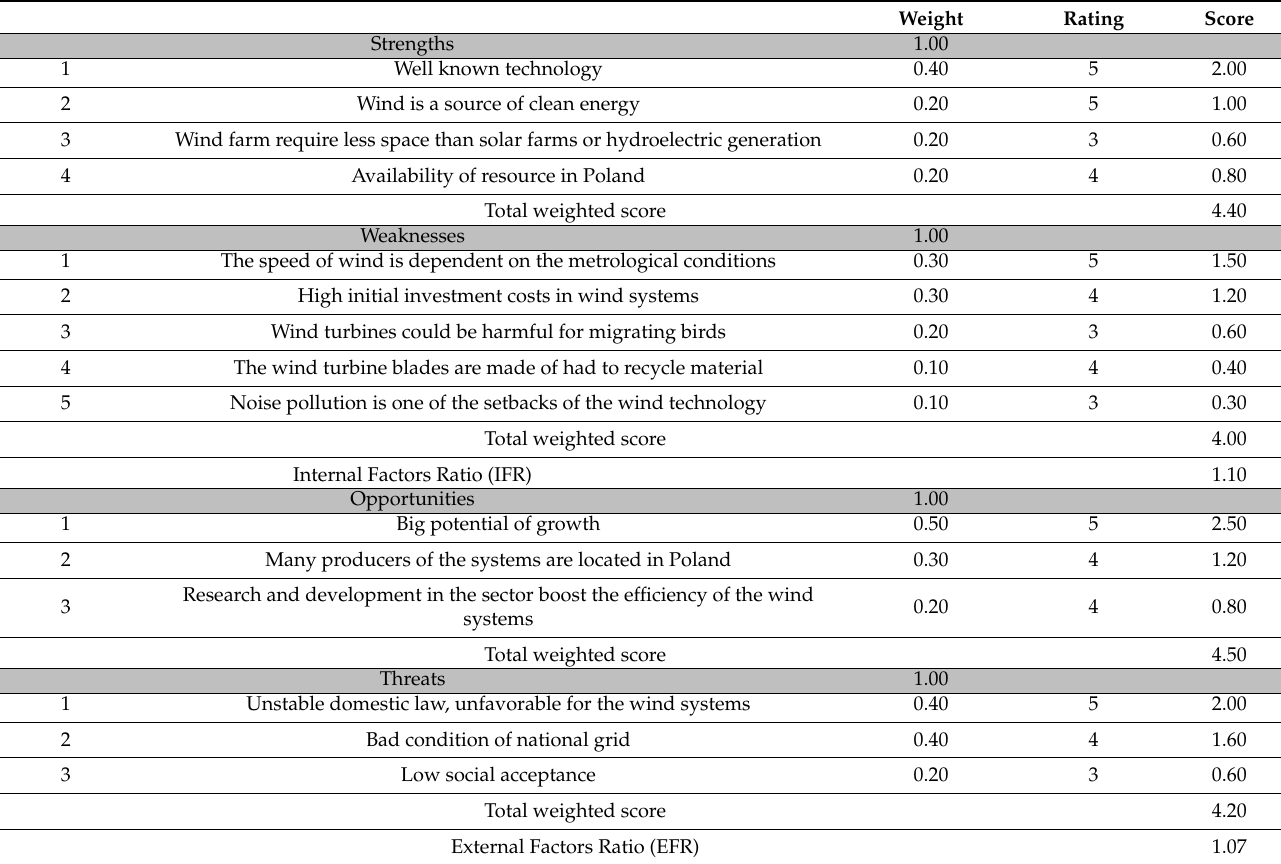
Figure 8. Wind systems—installed capacity (MW) and trends. Table 5 presents the the Weighted SWOT Analysis for Wind Systems in Poland. Table 5. Weighted SWOT analysis for wind systems in Poland.